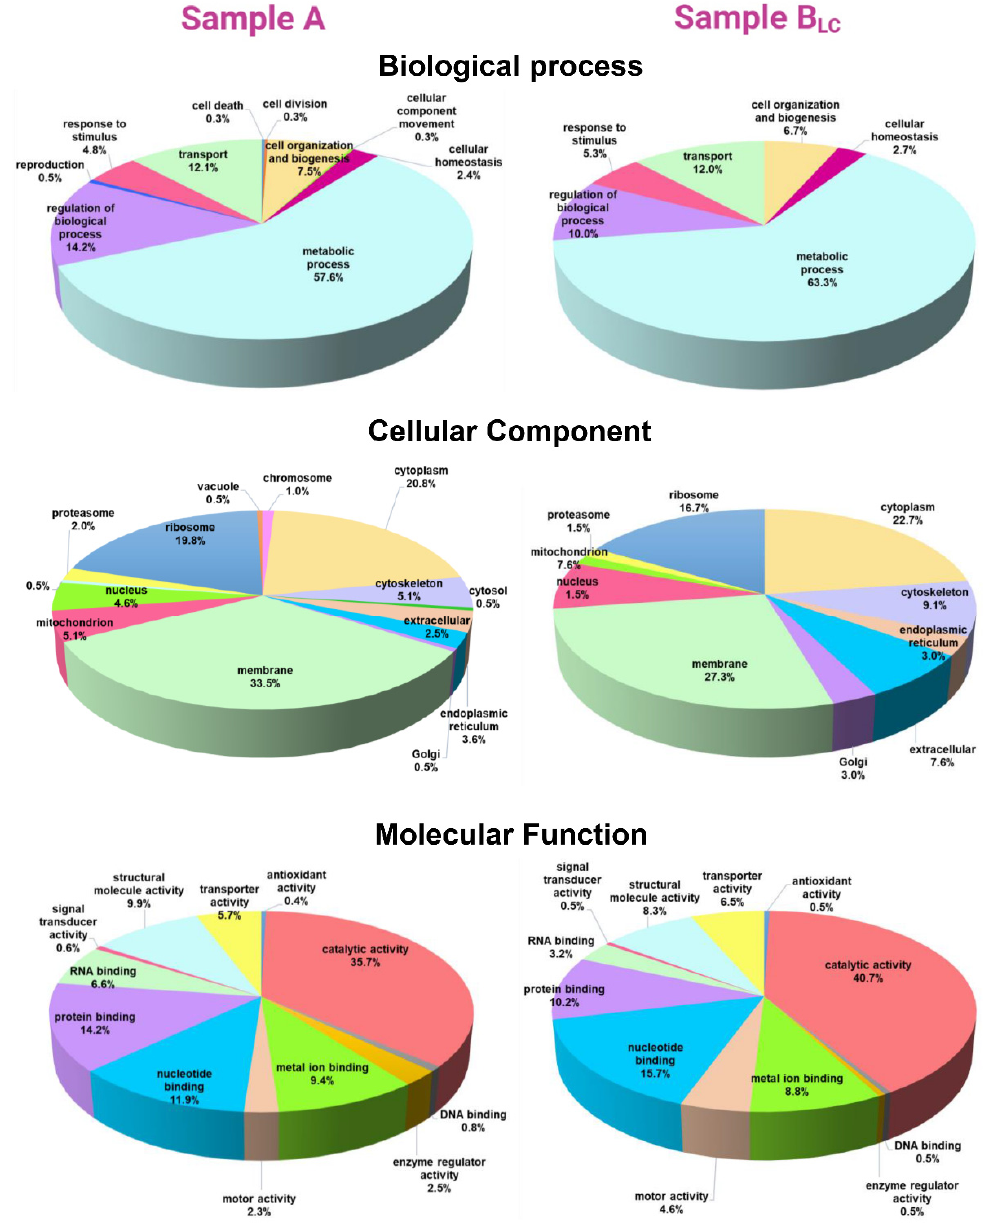
Figure 7. Pie chart of Gene Ontology (GO) distribution terms associated with the identified proteins.